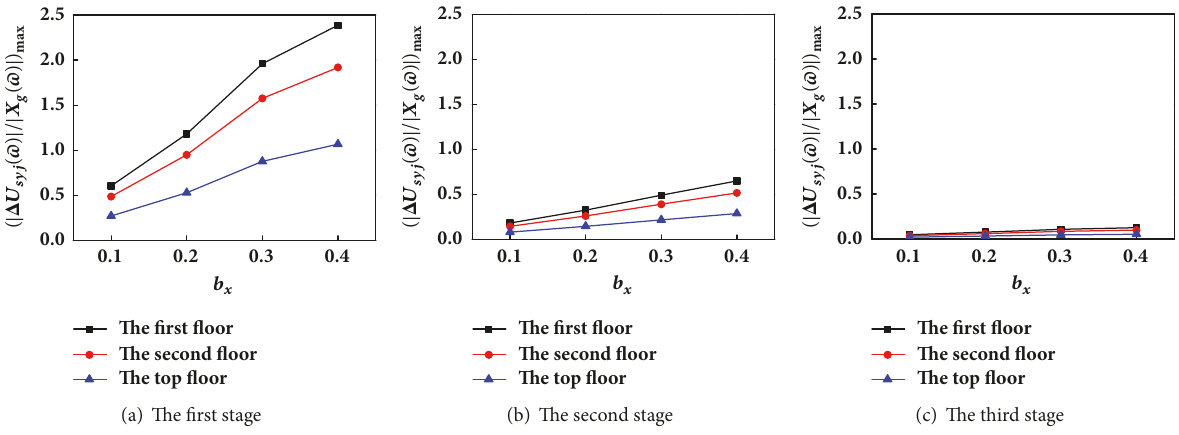
Figure 16: Interstory translation displacement in the 𝑦 direction under different 𝑏 𝑥